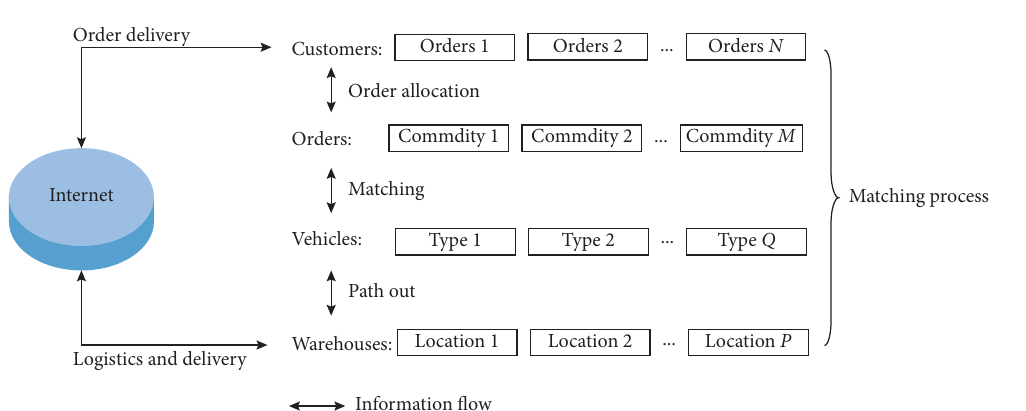
Figure 1: Schematic diagram of matching process.